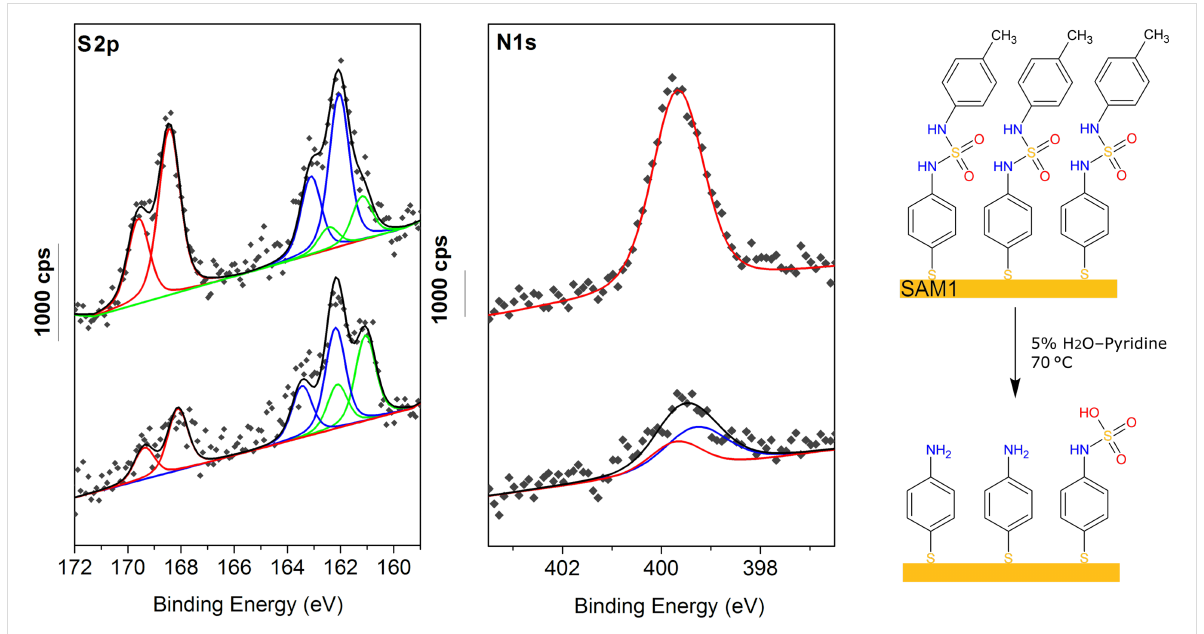
Figure 4: High resolution S2p and N1s XPS spectra of the SAM 1 before (top) and after hydrolysis (bottom). Right panel: Schematic view of the SAMs hydrolysis.